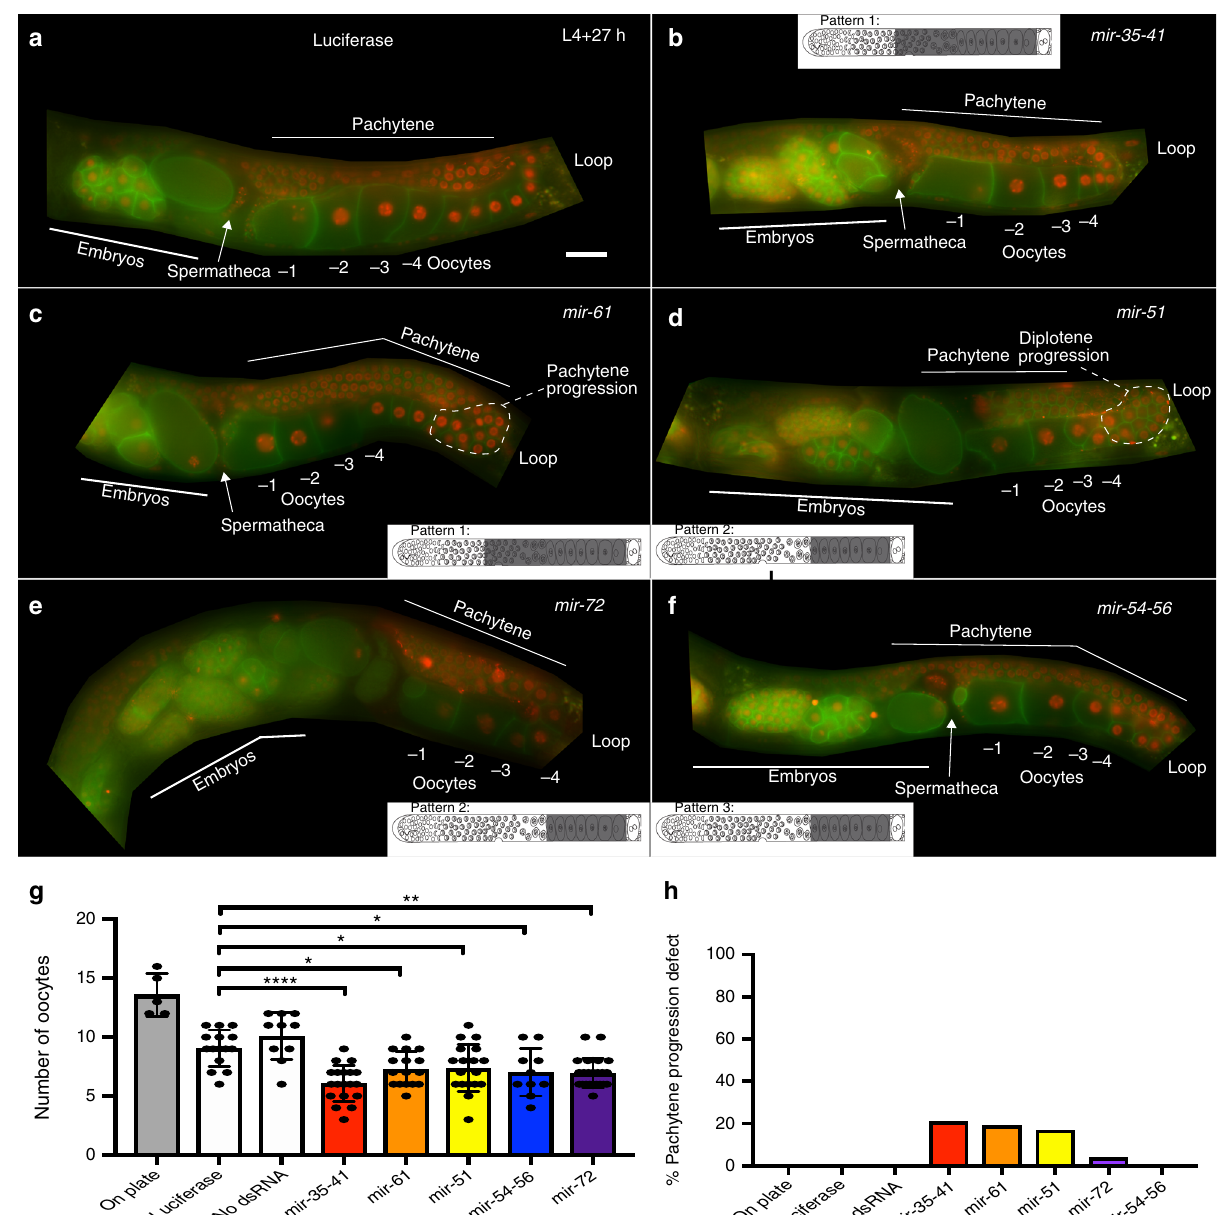
Fig. 4 RNAi mediated depletion of oocyte-expressed miRNAs reveals defects in meiotic progression and oocyte development. The photograph displays live imaging of germlines from whole animals bearing membrane GFP (green) and Histone 2B mCherry (red). The animal is oriented in dorsal (top) ventral (bottom) polarity. The schematic in each panel depicts the pattern of accumulation, gray indicates regions of positive localization. a Luciferase RNAi does not produce oocyte defects. See also Supplementary Fig. 12 for negative controls. b mir-35 – 41 RNAi results in a lower number of oocytes and delayed pachytene progression. c mir-61 RNAi results in a lower number of oocytes and delayed pachytene progression. d mir-51 RNAi causes oocyte disorganization and double row of diplotene oocytes, coupled with lower oocyte number. e mir-72 RNAi results in a lower number of oocytes. f mir-54 – 56 RNAi results in a lower number of oocytes. g Quantitation of oocyte number from each of the RNAi treatments. Each oocyte is numbered from diplotene stage (starting at the loop region). Each experiment was performed three times, ~20 – 25 animals assayed per replicate and statistical signi fi cance was calculated by one-way ANOVA with Bonferroni ’ s correction. **** P < 0.0001, ** P < 0.001, * P < 0.01. ±SD. Scale bar: 20 μ M. h Percentage of animals displaying pachytene progression defects quanti fi ed for each RNAi treatment taking all three replicates into